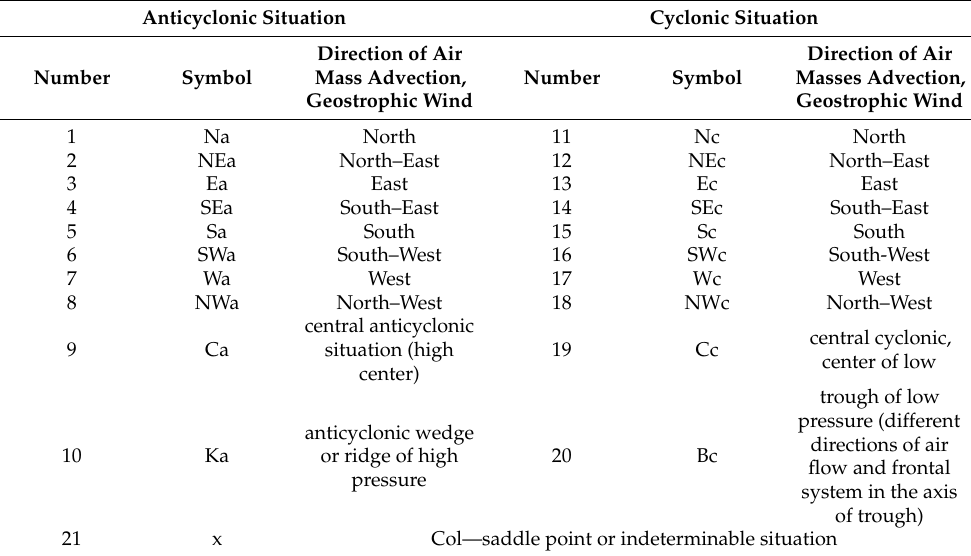
Table 2. Types of atmospheric circulation by Nied´zwied´z